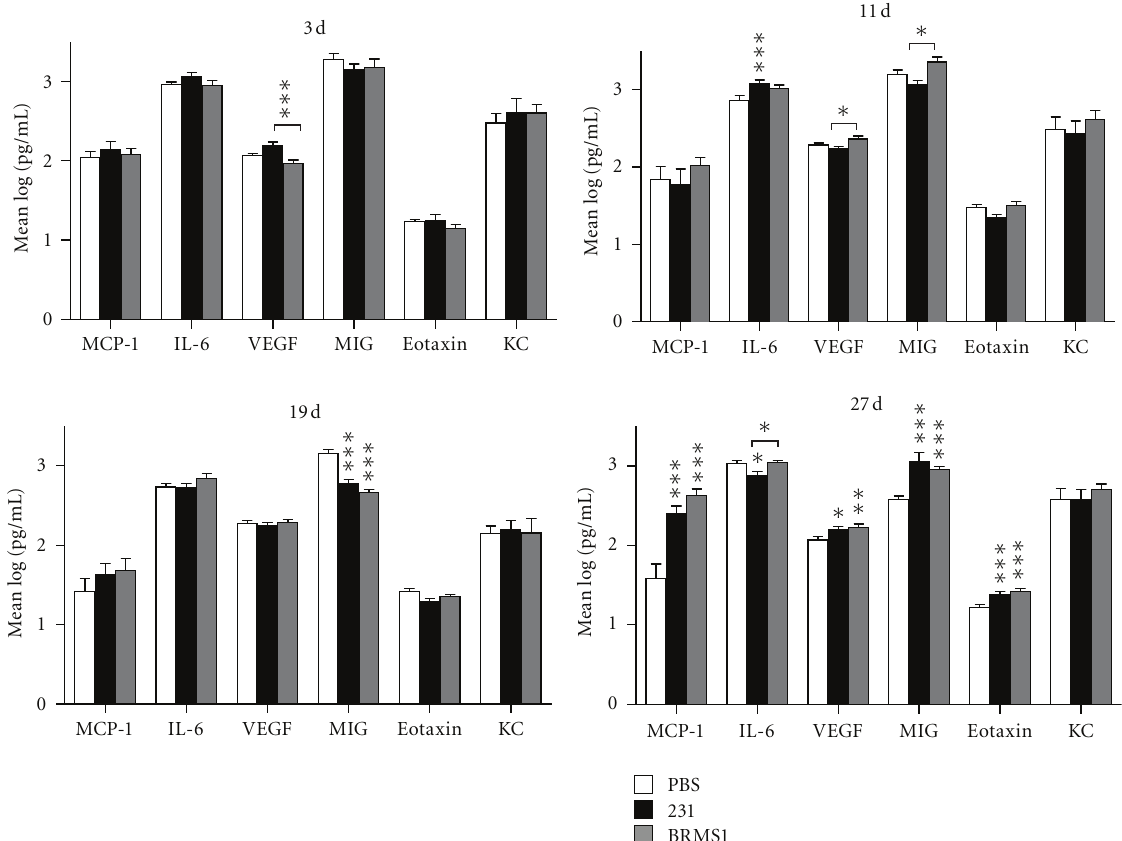
Figure 3: Comparison of bone cytokine levels in mice inoculated with PBS, MDA-MB-231 GFP or MDA-MB-231BRMS1 GFP ,cells. Mice were inoculated and femurs processed as described in Section 2. Cytokine values were log 10 transformed for analysis and graphic comparison of each postinjection group. Statistical significance is shown for comparison to PBS unless otherwise noted with a bracket. The only significant di ff erence shown on day 3 post injection was for VEGF which was higher in 231-injected mice than in BRMS1. On day 11, VEGF and MIG were slightly higher in BRMS1 injected mice than in 231, while IL-6 values were higher in 231 injected mice than in PBS. On day 19, the only cytokine that varied significantly was MIG, with higher values for 231 and BRMS1 mice than in the control animals. In later stage metastasis (day 27), the levels for 4 (MCP-1, VEGF, MIG, and eotaxin) of the 6 cytokines were significantly higher in both the 231-and the BRMS1- injected mice when compared to PBS. IL-6 levels were lower in animals injected with 231 cells. KC levels did not vary between groups at any of the time points. ∗∗∗ P < 0 . 001; ∗∗ P = 0 . 01–0 . 001; ∗ P = 0 . 05–0 . 01. n =